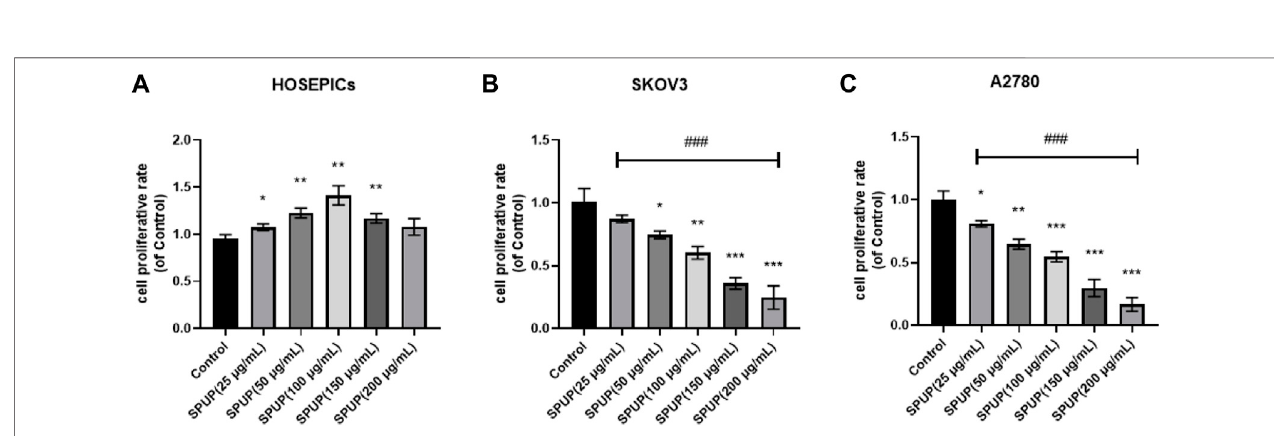
FIGURE 2 | Effect of SPUP on the proliferation activity of two kinds of OC cells and human normal ovarian epithelial cells. Compared with the control group, * p < 0.05, ** p < 0.01, *** p < 0.001; comparison between groups with different concentrations of SPUP, ### p < 0.001. (A) HOSEPICs, (B) SKOV3, and (C) A2780.